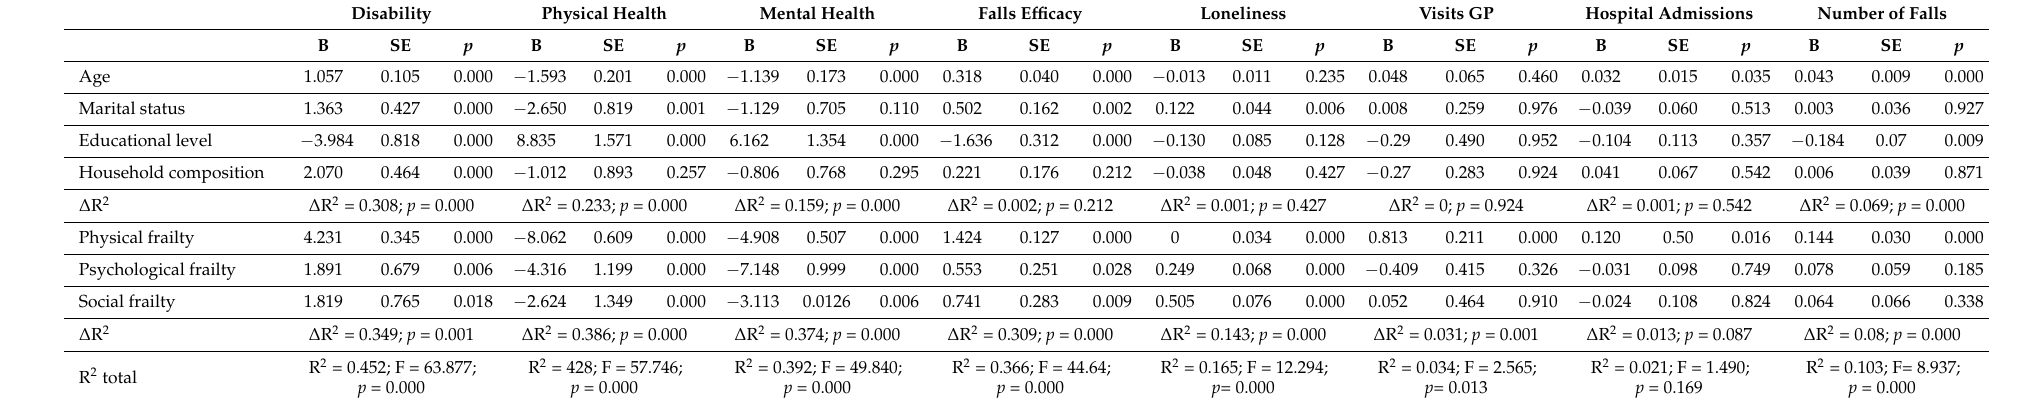
Table 5. LONGITUDINAL Effects of Socio-demographic Characteristics and Frailty Domains on Adverse Outcomes: Linear Regression Analyses.